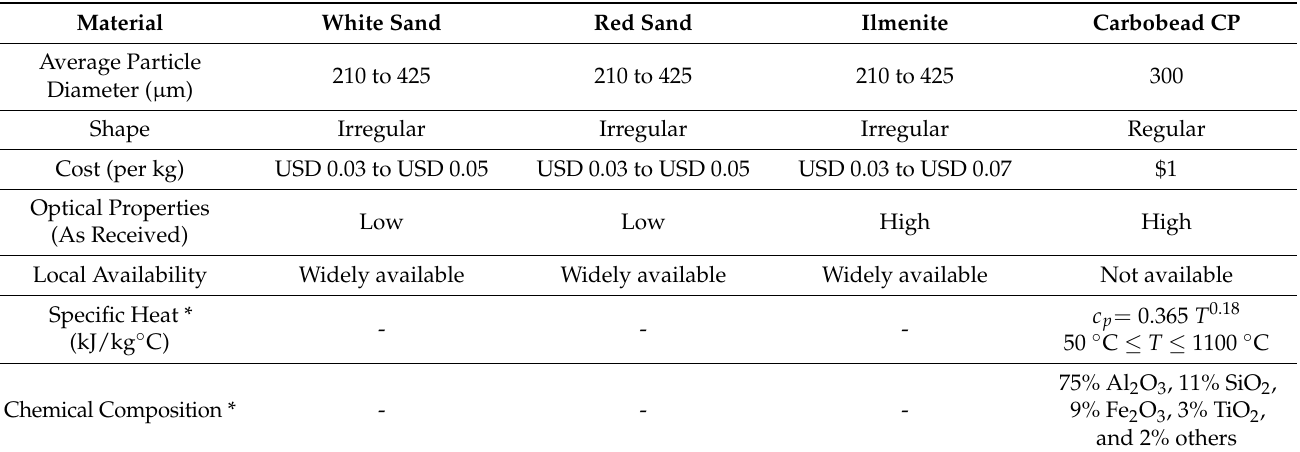
Table 1. Characterization of candidate particulate